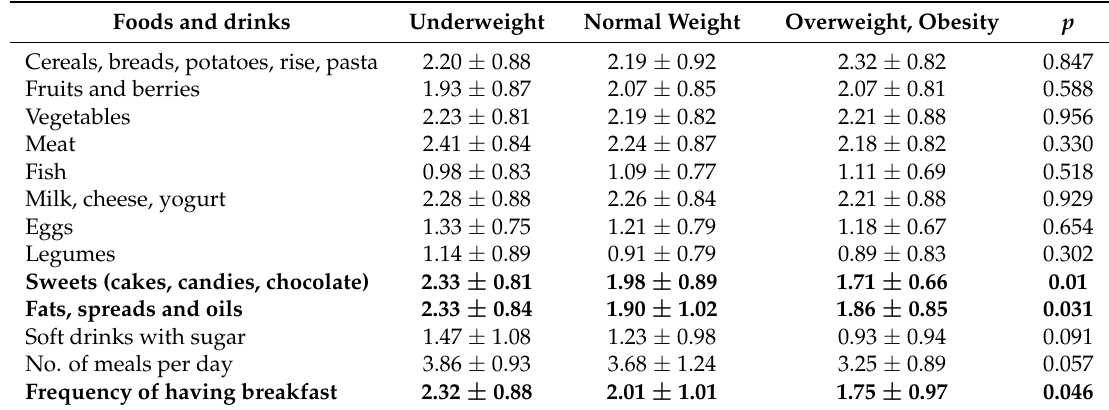
Table 4. Comparison of nutrition habits between body mass groups in girls (m ± SD) 1 , ( n = 579). Foods and drinks